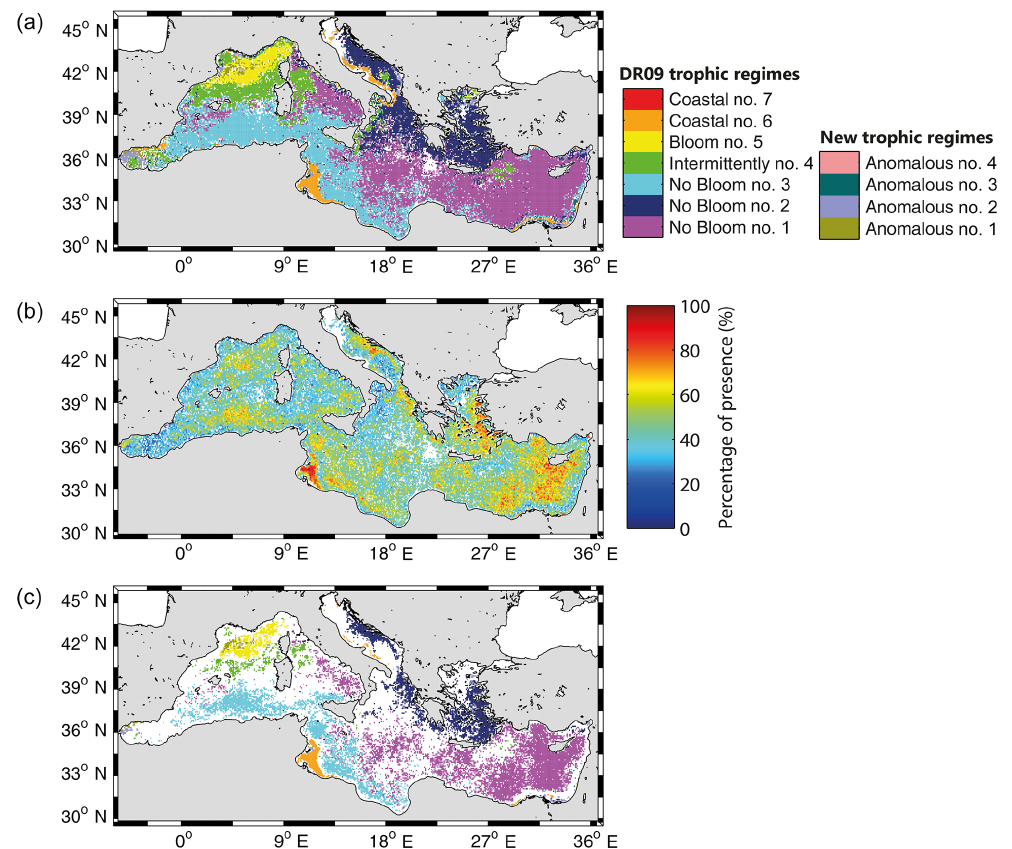
Figure 5. (a) Map of the most recurrent bioregions for the 16-year period (i.e., the dominant regimes), obtained with our method. The white pixels indicate where data are mostly not available. (b) Map of the percentage of presence of the dominant regimes. (c) Map of the most recurrent bioregions as in Fig. 5a, but displaying only pixels with a percentage of presence ≥